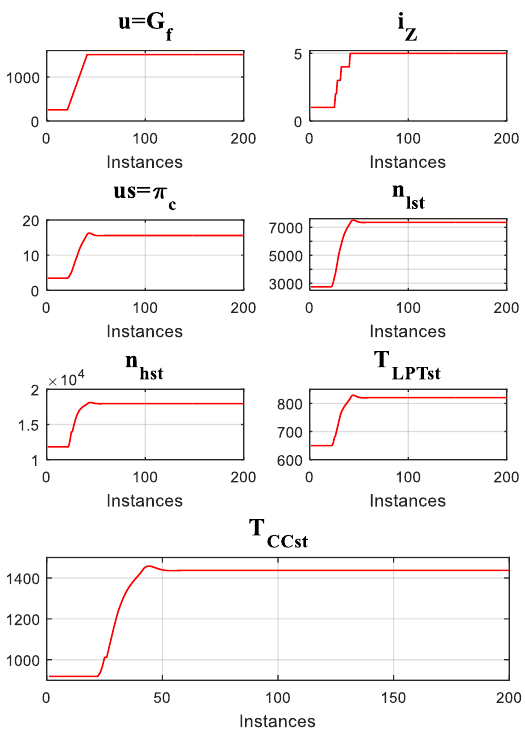
Figure 3. Simulation of static values (static model within the hybrid model).